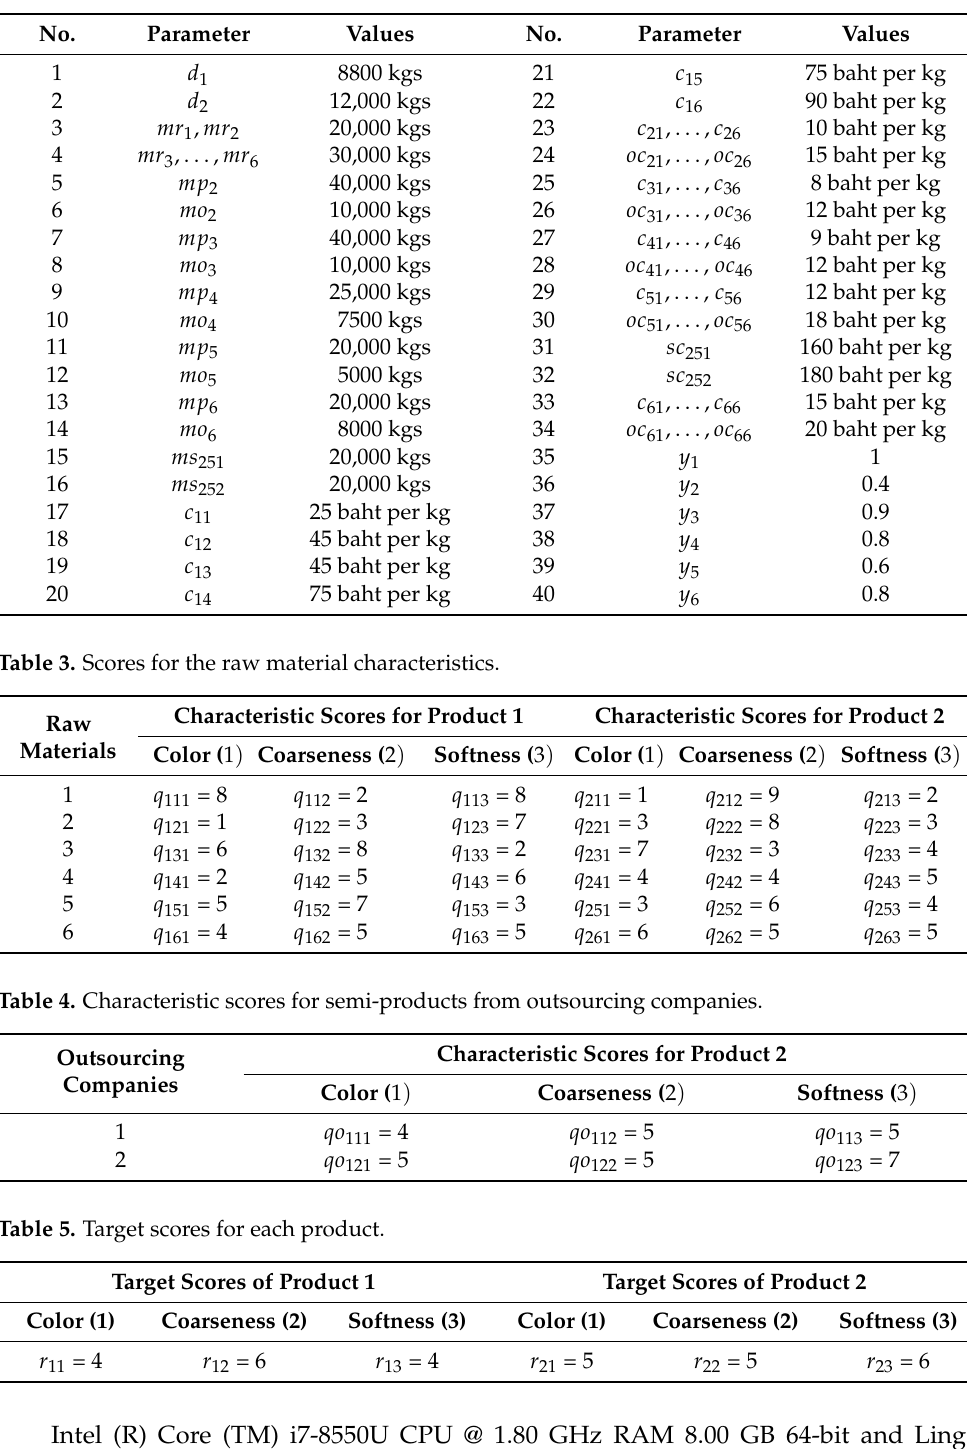
Table 2. Parameters of the case study.